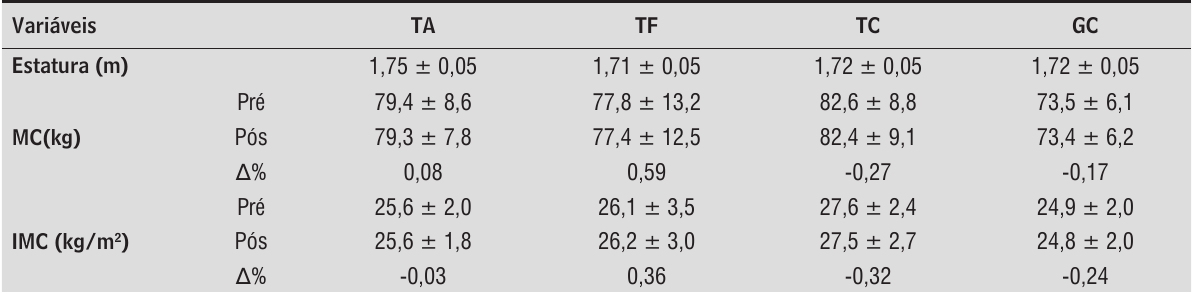
Tabela 1 - Variáveis antropométricas pré e pós 16 semanas de treinamento aeróbio (TA, n = 13), treinamento de força